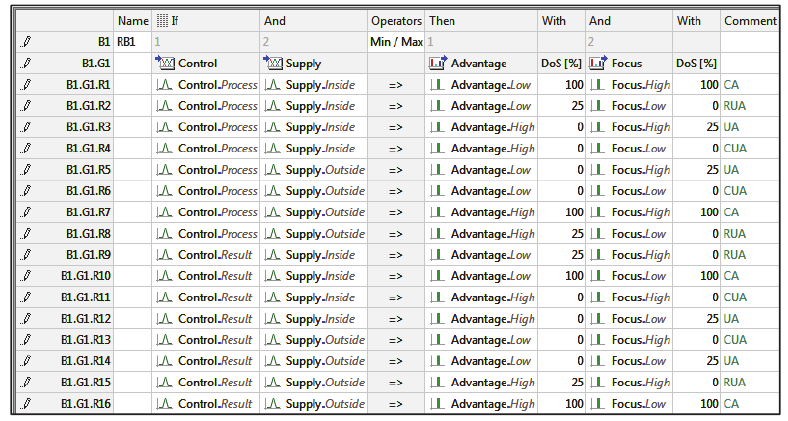
Fig. 3. Rules defined in software based on fuzzy